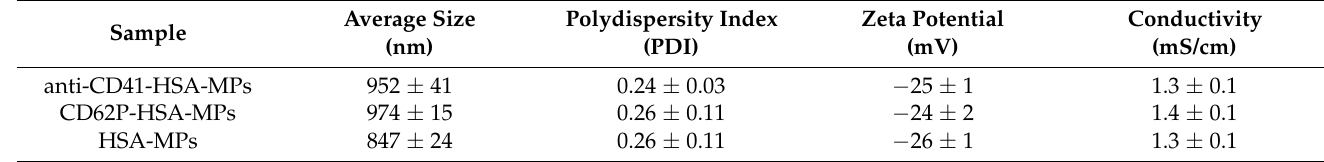
Table 1. Particle size and zeta potential.